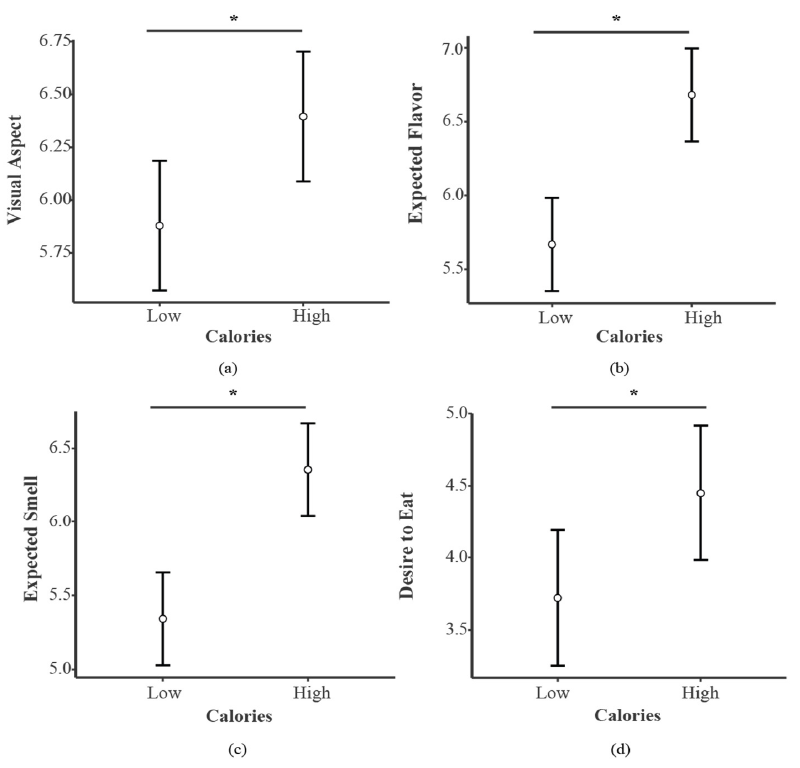
Figure 3. Main results for Calories in each evaluated dimension, i.e., ( a ) Visual Aspect, ( b ) Expected Flavor, ( c ) Expected Smell and ( d ) Desire to Eat. Bars indicate confidence intervals (95%). * p < 0.05.